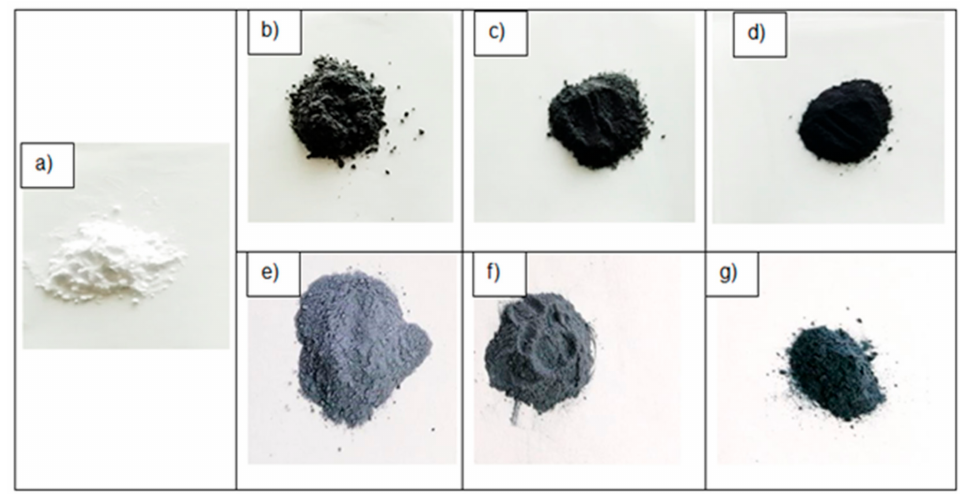
Figure 3. Pictures of microcapsules MPCM32D in powder form: unmodified ( a ) and shell-modified with different mass fraction: ( b ) MWCNTs 1 wt.%, ( c ) MWCNTs 5 wt.%, ( d ) MWCNTs 10 wt.%, ( e ) PEDOT: PSS 1 wt.%, ( f ) PEDOT: PSS 5 wt.%, ( g ) PEDOT: PSS 10 wt.%.